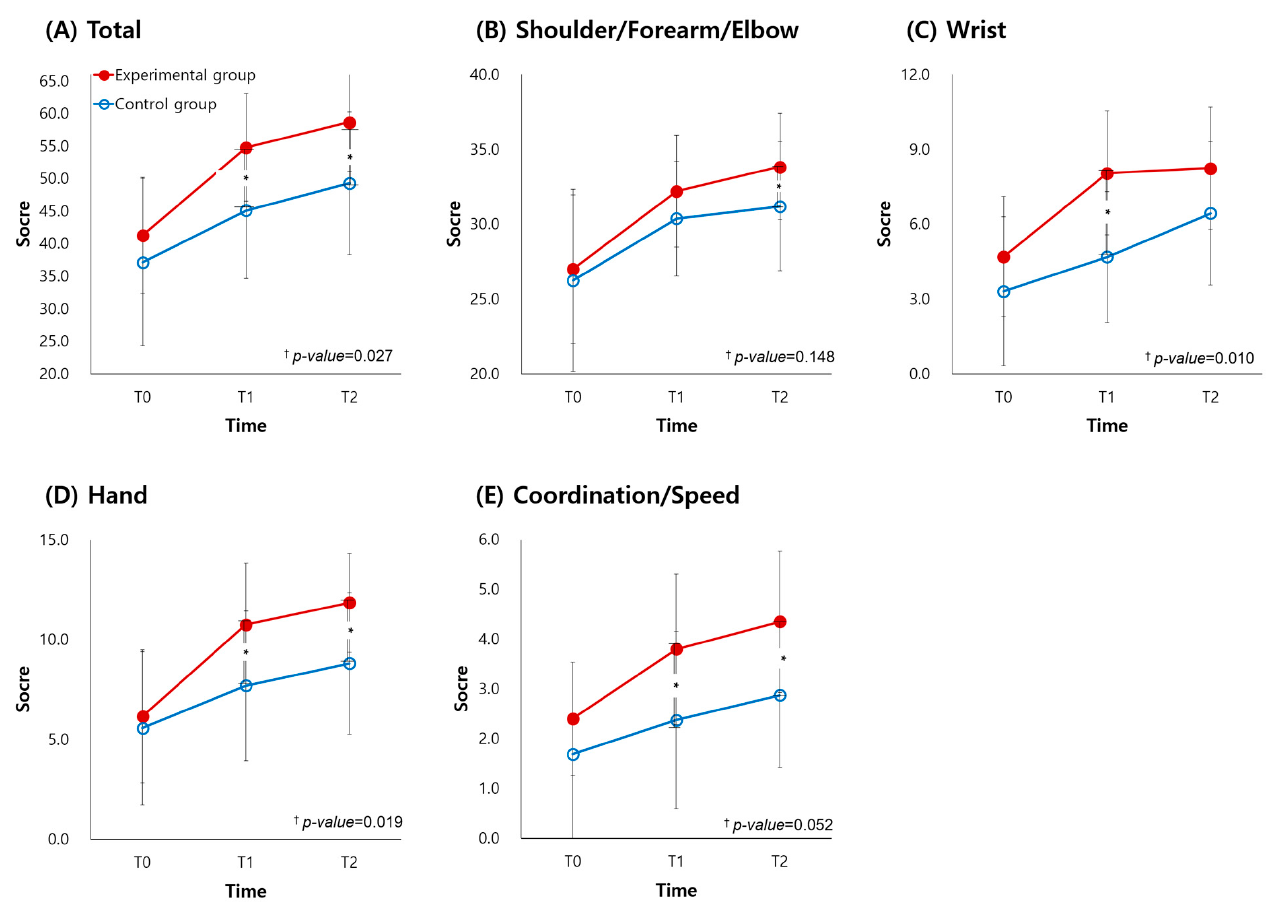
Figure 3. Group analysis of Jebsen-Taylor hand function test in experimental and control groups. T0, before the intervention; T1, immediately after the intervention; T2, four weeks after the intervention. * p < 0.05 between-group comparisons according to independent t -test or Mann-Whitney U test for continuous variables as appropriate after Bonferroni’s correction. † p -value according to repeated measure analysis of variance.